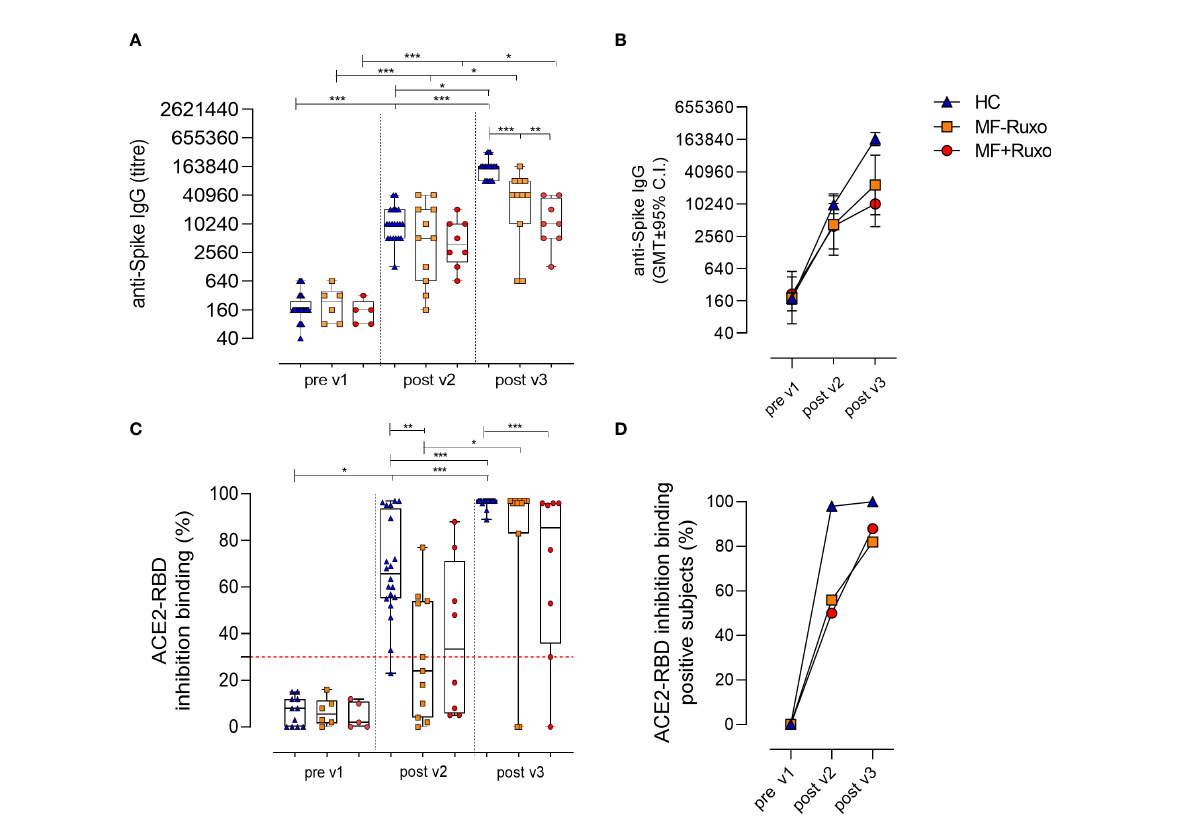
FIGURE 2 Humoral immune response against SARS-CoV-2 in patients with myelo fi brosis (MF) after the second and the third dose of mRNA vaccine. (A) Spike-speci fi c IgG titres were assessed by ELISA in plasma of patients with MF, treated or not with ruxolitinib (Ruxo), and healthy controls (HC), at baseline (pre v1), and after two and three vaccine doses. Antibody end point titres were expressed as the reciprocal of the sample dilution reporting double the background OD value. (B) Time course of spike-speci fi c IgG in plasma collected at the baseline (pre v1) and after two (post v2) and three (post v3) doses of mRNA SARS-CoV-2 vaccine. (C) SARS-CoV-2 surrogate virus neutralization assay was tested at baseline (pre v1), post v2 and post v3 in plasma by evaluating ACE2/RBD binding inhibition activity. Results are expressed as ACE2/RBD binding inhibition percentage with box and whiskers diagram showing all subject values. Inhibition values ≥ 30% are considered a positive result according to the manufacturer indication. (D) Percentage of subjects developing ACE2/RBD inhibition binding positive values ( ≥ 30%) in different groups. Kruskal- Wallis test, followed by Dunn ’ s post test for multiple comparisons, was used for assessing statistical differences between groups. Unpaired Mann-Whitney test was used to assess statistical difference for each group at different time point. *P ≤ 0.05; **P ≤ 0.01; ***P ≤